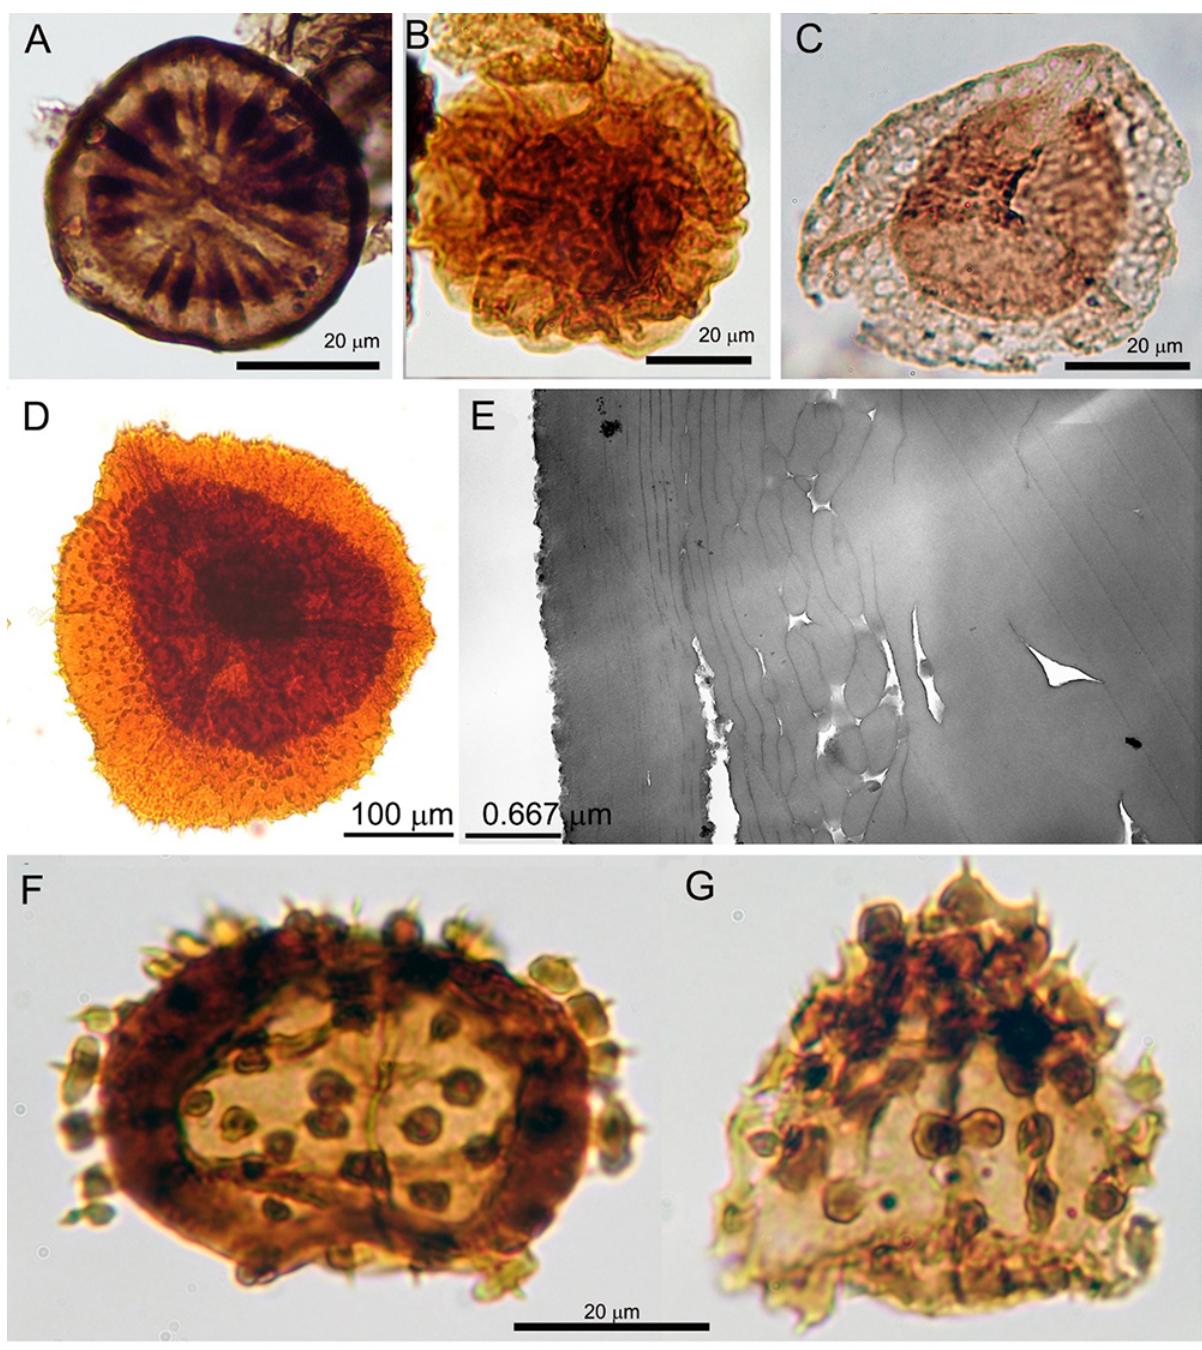
Figure 4 ( A ) Emphanisporites annulatus ; index miospore for the annulatu-sextanti Zone (Lower Devonian), Bukow Góra quarry, Holy Cross Mountains (photo P. Filipiak). ( B ) Diducites versabilis , important miospore for the late Famenian palynostratigraphy, Kowala quarry, Holy Cross Mountains (photo P. Filipiak). ( C ) Retispora lepidophyta , the most important cosmopolitan species for dating the D/C boundary, late Famennian, Kowala quarry, Holy Cross Mountains (photo P. Filipiak). ( D ) Grandispora ciliata , Devonian (photo E. Turnau). ( E ) e same species, fragment of proximal wall showing the inner body and inner part of the outer envelope (photo N. Zavialova). ( F,G ) Two mutated miospores Vallatisporites ? from the Devonian/Carboniferous boundary in the Kowala quarry, Holy Cross Mountains (photo P.